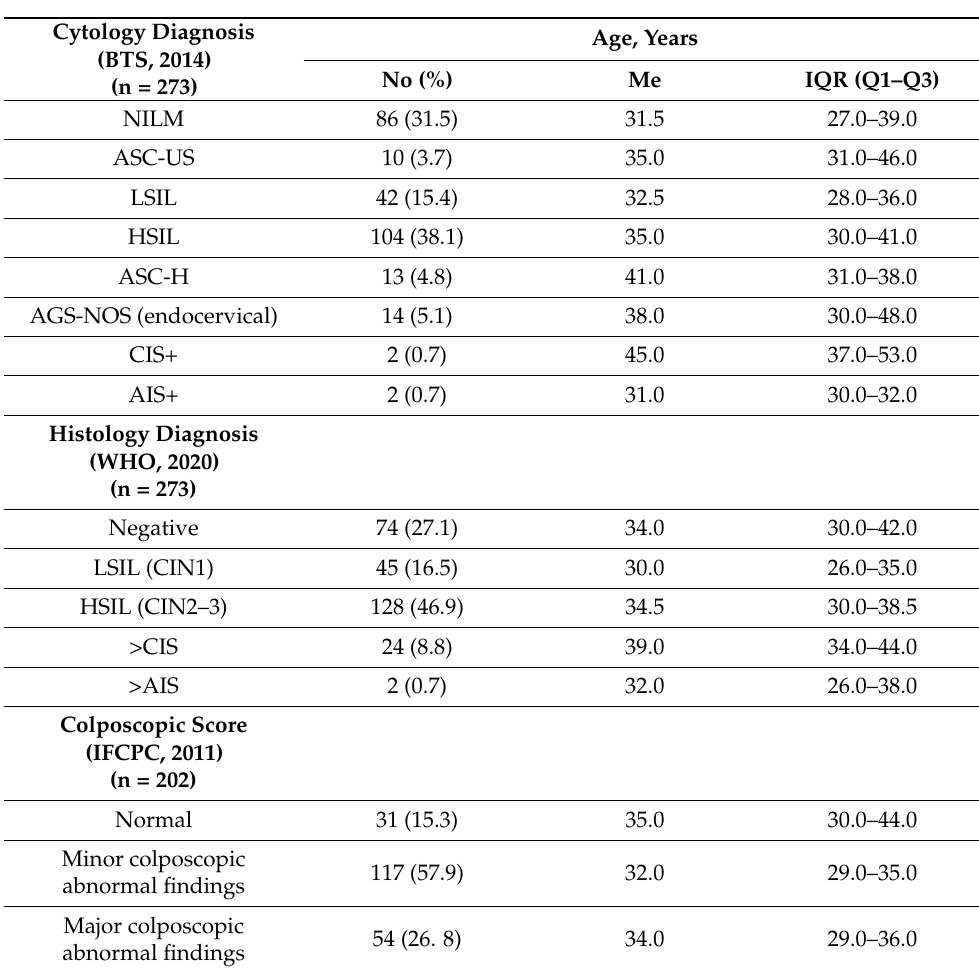
Table 1. Comparison of mean age between cytologic, histologic, and colposcopic patient